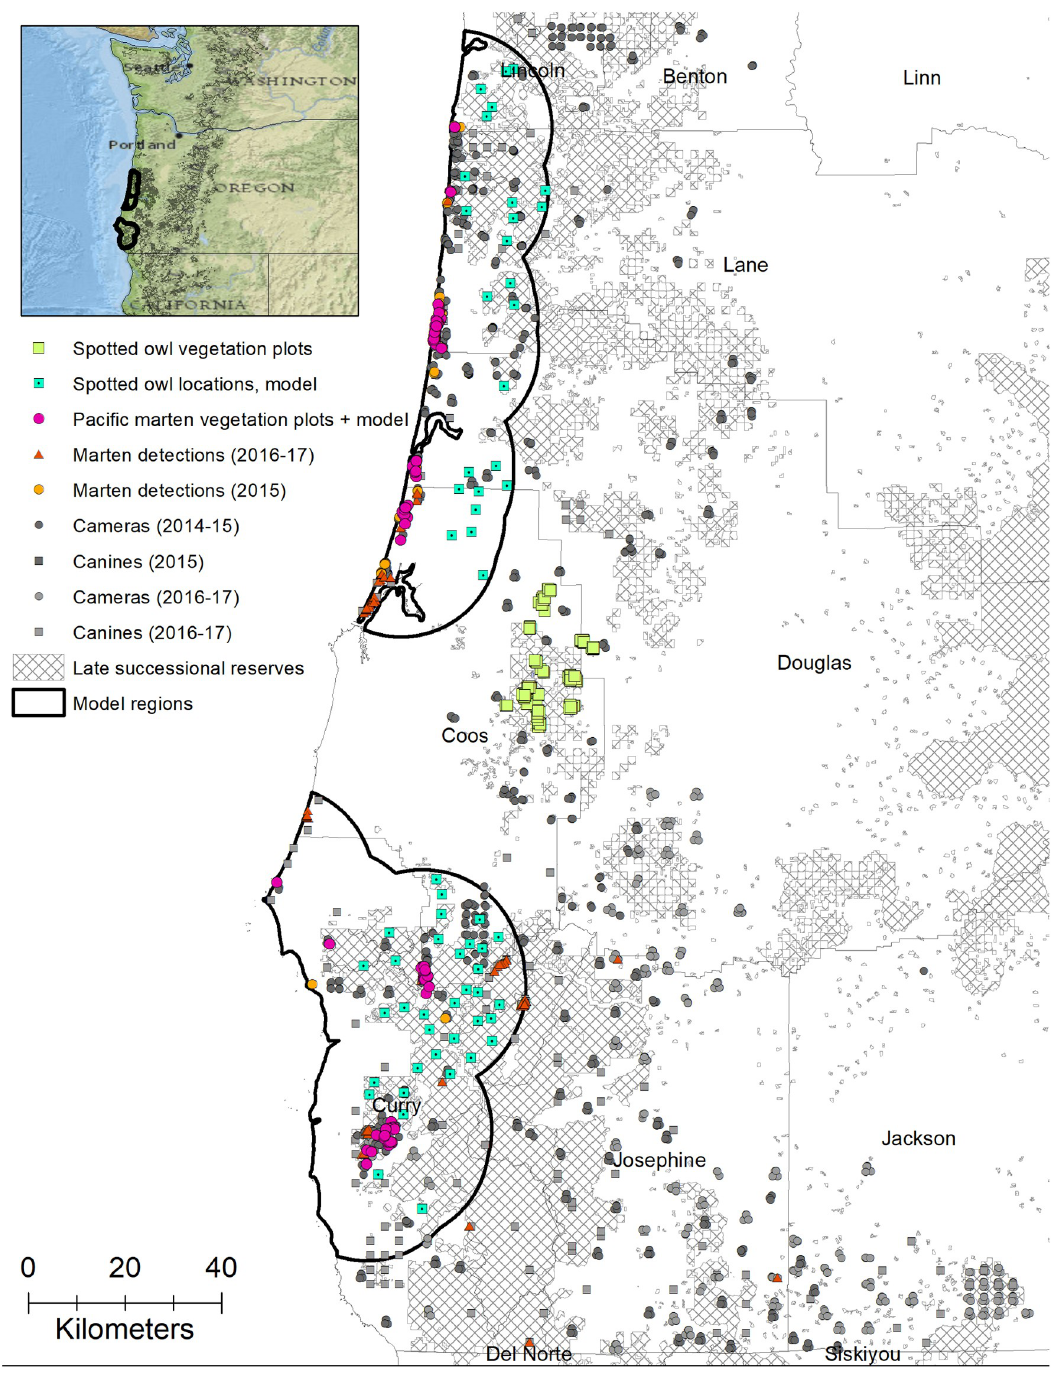
Fig 1. Study area. Survey and modeling regions to compare northern spotted owl ( Strix occidentalis caurina ) and coastal Pacific marten ( Martes caurina humboldtensis ) predicted habitat. We radio-tagged northern spotted owls and collected data in the core of their range (yellow squares). Both spotted owl (blue squares with a dot) and Humboldt marten distribution surveys (pink circles) were used for modeling predicted distributions, with the extent bounded within 10 km of all Humboldt marten locations. We included more recent marten survey effort (dark grey) and detections (red triangles) to represent surveyed areas were consistent with marten distribution. Cross-hatched areas were designated as late-successional forest reserves under the 1994 Northwest Forest Plan. Imagery sources: Esri, DigitalGlobe, GeoEye, Earthstar Geographics, CNES/Airbus DS, USDA, USGS, AeroGRID, IGN, and the GIS User Community.